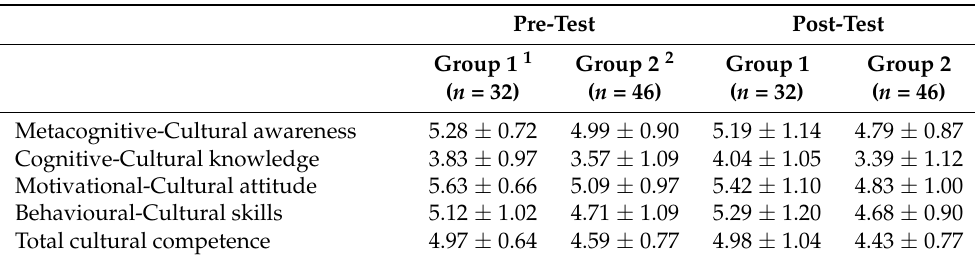
Table 2. Descriptive statistics (mean ± SD) of cultural